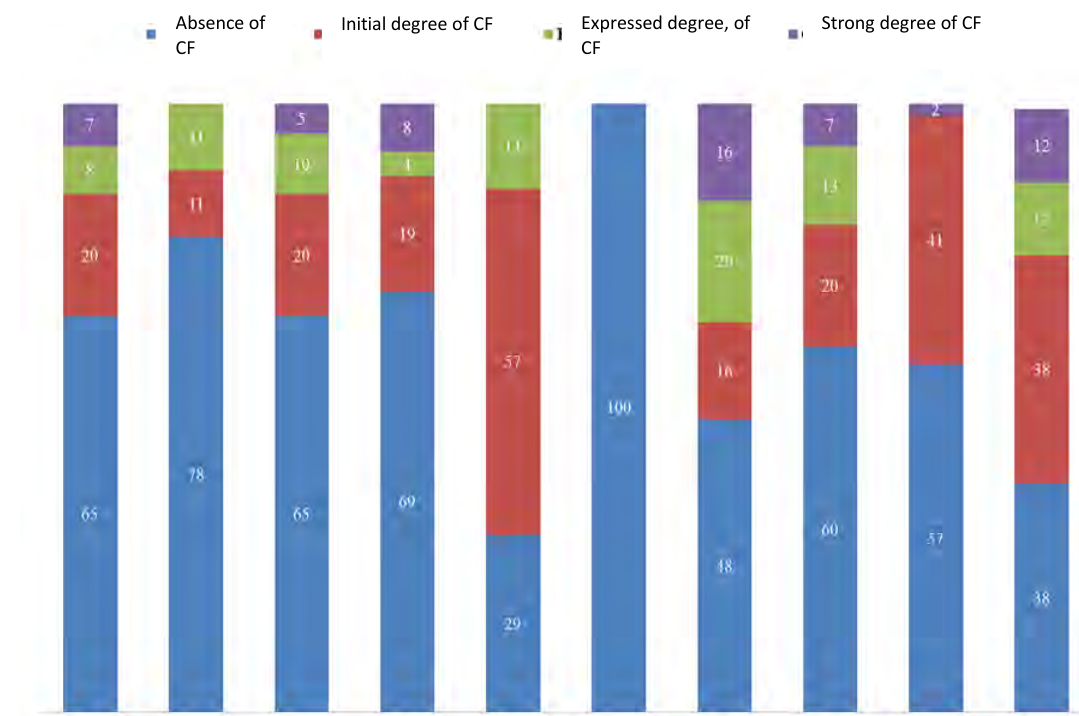
Fig 2. Symptoms of chronic fatigue of different degree in the questioned sportsmen of different kinds of sports The received data can witness that in football, light athletics, swimming, wrestling and hockey training and competition loads are too high for some sportsmen and restoration processes in their organisms are inhibited. It is necessary to pay attention of coaches, methodic specialists and medical personnel to the demand in correction of trainings’ building and character for such sportsmen. Besides, it is necessary to pay attention to full and consequent application of sports workability restoration methods and means (day regime, control over functional systems’ state and so on) in kinds of sports, in which manifestations of chronic fatigue is the most frequent. Besides, it is important to use means, oriented on increase of organism’s non specific resistance at all stages of training and competition processes [15]. Recreational means shall be included in general plan of sportsman’s training in close connection with general organization of training regime [2,